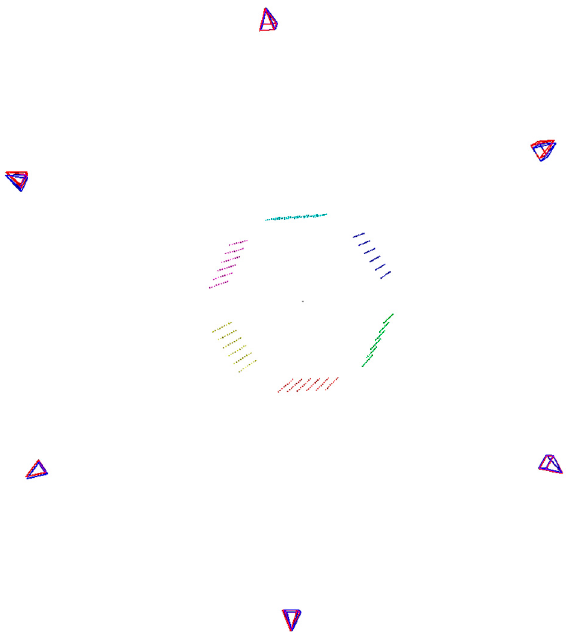
Figure 11. A symbolic representation of the calibration pattern and the determined positions of the cameras (red—determined directly through the image analysis; blue—after correcting the x -axis position). Each side of the calibration pattern is drawn in different color. The points represent the internal corners of each chessboard used in the global calibration procedure.